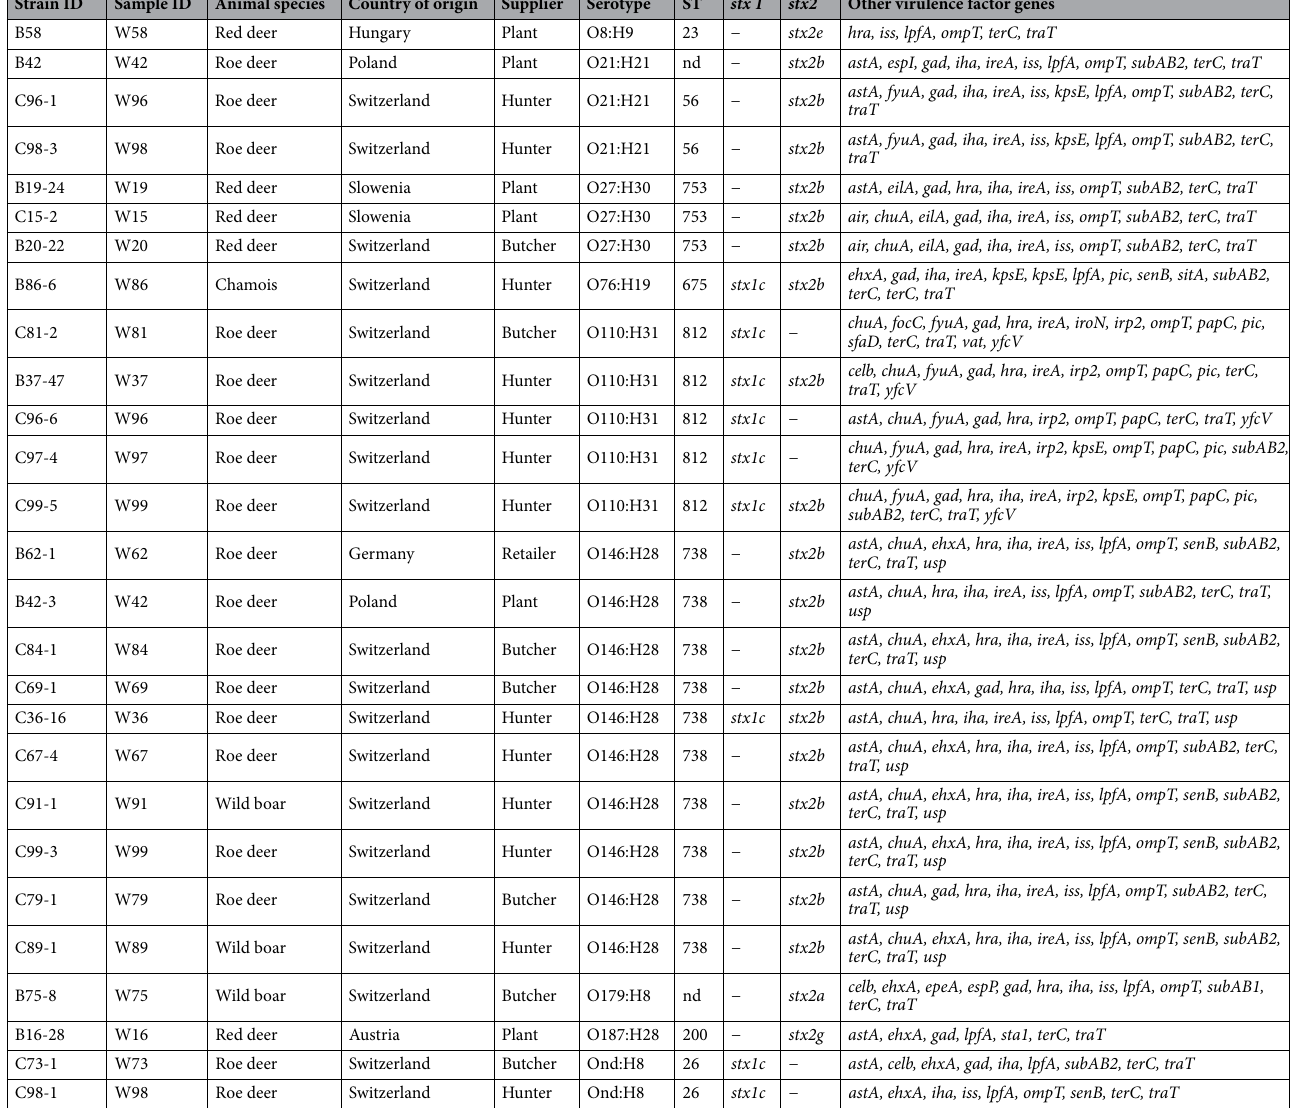
Table 2. Characteristics of 27 Shiga toxin-producing Escherichia coli (STEC) isolated from game meat from different animals and countries. nd, not determined; ST, sequence type; +, presence of gene(s); −, absence of